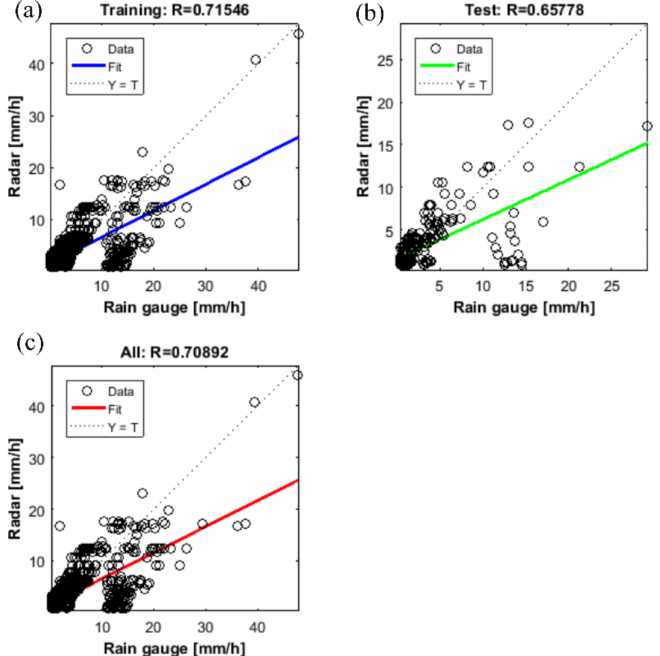
Figure 10. Scatter plots of radar rainfall estimates based on ANN versus rainfall measurements from the gauges. ( a ) training, ( b ) testing and ( c ) all regressions of the reflectivity for all rainfall intensity. The color lines are fitted line and the dashed lines are 95% confidence bounds of the fitted